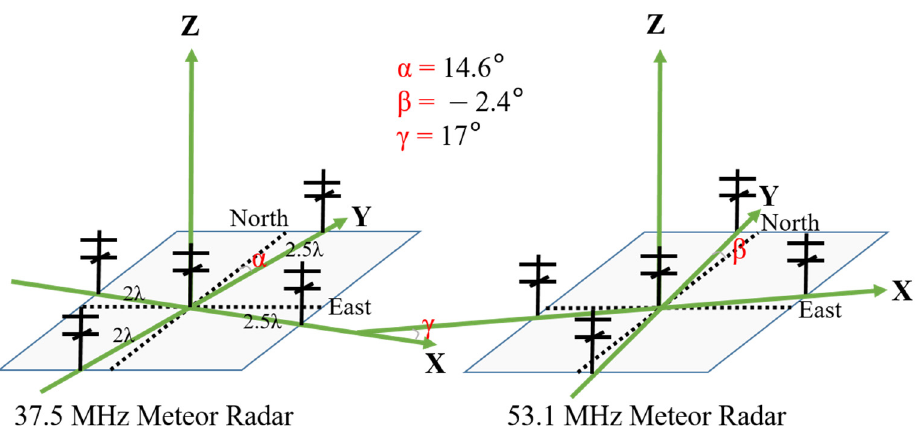
Figure 6. Schematics of the relative positions of the receiver antenna arrays of the two MR systems. The reference direction may exhibit angular deviations of α and β and a total angular deviation γ . The antenna arrays refer to the east–north–up coordinate system.